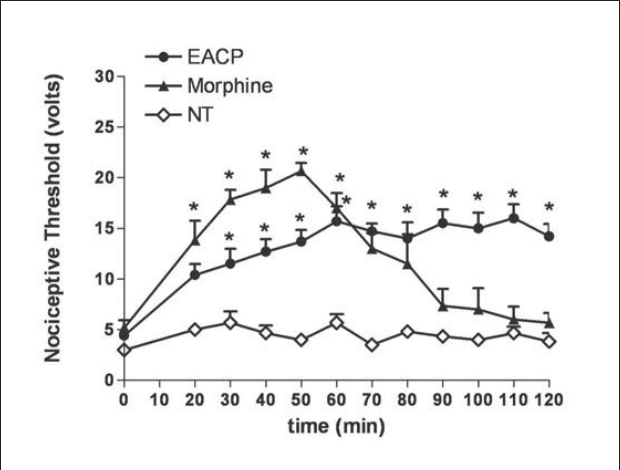
Fig. 2. Evaluation of analgesic effect differences between low-frequency electroacupuncture (EACP) and morphine in rabbit tooth pulp assay. The nociceptive threshold was measured before and after EACP procedure or morphine injection every 10 min up to 120 min. Animals were treated with EACP (Yintang, ST4, ST5 acupoints; 2 Hz, 30 mA; 20 min before test up to 120 min), morphine (5mg/kg; 1 mL; e.v.; 20 min before test) or saline (NT; 1 mL; e.v.; 20 min before test). The points represent the means ± SEM of 6-12 animals per group. Asterisks indicate statistically significant differences between the NT group and the others (*p<0.05; ANOVA followed by Turkey’s